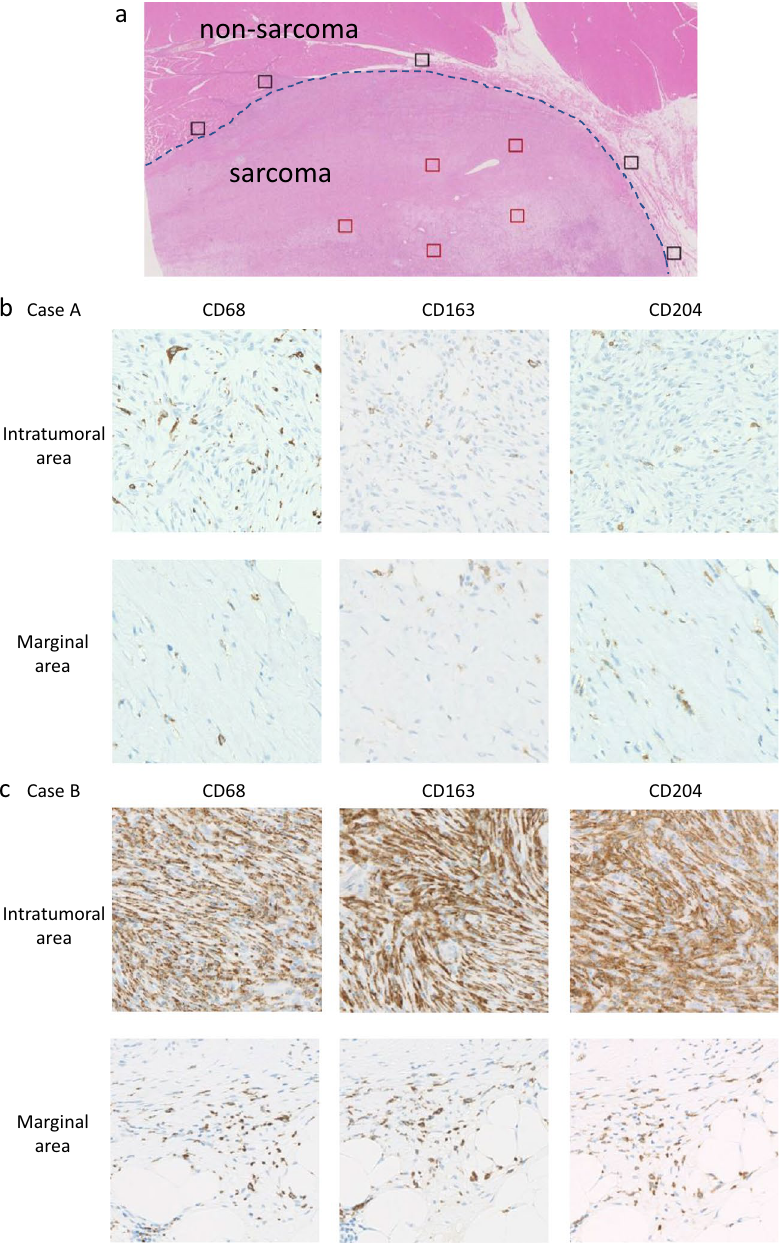
Figure 1. A representative case demonstrating the areas that were counted. Red square, intratumoral area; black square, marginal area ( a ). Representative immunohistochemical images of the intratumoral and marginal areas in case A (FNCLCC Grade 1 sarcoma) ( b ), and case B (FNCLL Grade 3 sarcoma) ( c ).